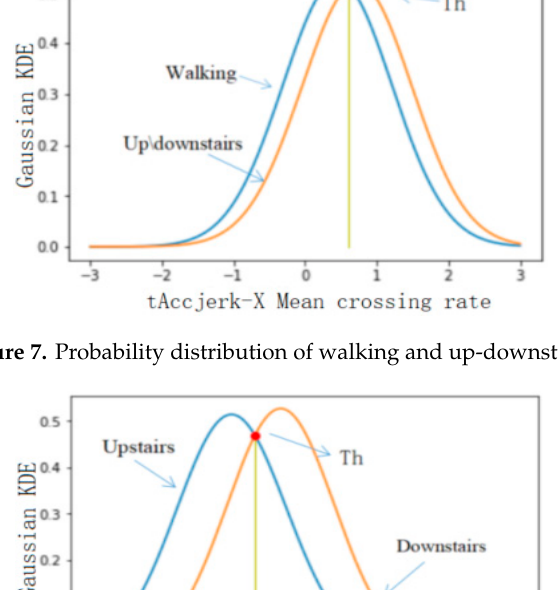
. Figure 9. Probability distribution of standing, sitting, and lying. Figure 10. Probability distribution of sitting and lying. 5. Discussions Multiple classification models (decision tree, linear regression, Gaussian process, and SVM) were used to further evaluate the accuracy of the classification at six levels, as shown in Table 12. The selected optimal feature set was input into the SVM classifier to train the classification model, and the 27th–29th people in the database were used for cross-validation to calculate the average precision value. It can be observed that the five classification levels can achieve a satisfactory classification effect. According to the experiments presented in the literature [44], when the proportion of the training data set is 70%~90%, the accuracy of the decision tree algorithm is relatively high, and the proportion of the training set selected in this paper was 70%. This method verifies the proportion of the best training set and test set corresponding to the SVM, linear regression, and the Gaussian process, and verifies that its classification accuracy can reach a high level through cross-validation. Figure 11 shows the total accuracy of classification for six BAs and PTs using SVM, a decision tree (DT), linear regression (LR), the Gaussian process (GP), and threshold classification (TH) in six levels. In general analysis, the method of threshold classification has a better effect. As shown in Figure 11, the classification accuracy of the five classifiers is higher in the fifth layer (that is, to distinguish between sitting and lying).